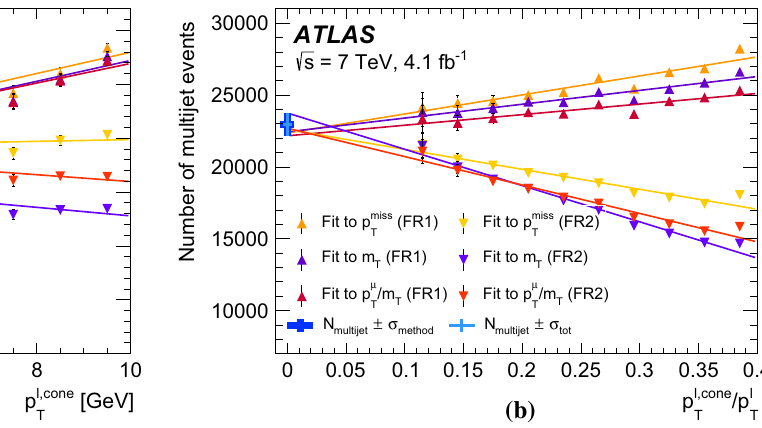
Fig. 18 Estimated number of multijet-background events as a func- extrapolations are indicated by the solid lines. The thick crosses show the results of the linear extrapolation of the background estimate to the tion of the lower bound of the isolation-variable range used to define signal region, including uncertainties from the extrapolation only. The the control regions, for a electron and b muon decay channel. The thin crosses also include the uncertainty induced by the contamination estimation is performed for the two regions FR1 and FR2 and three / m of the control regions by EW and top-quark processes distributions p miss , m T , and p (cid:7) T , as described in the text. The linear T T